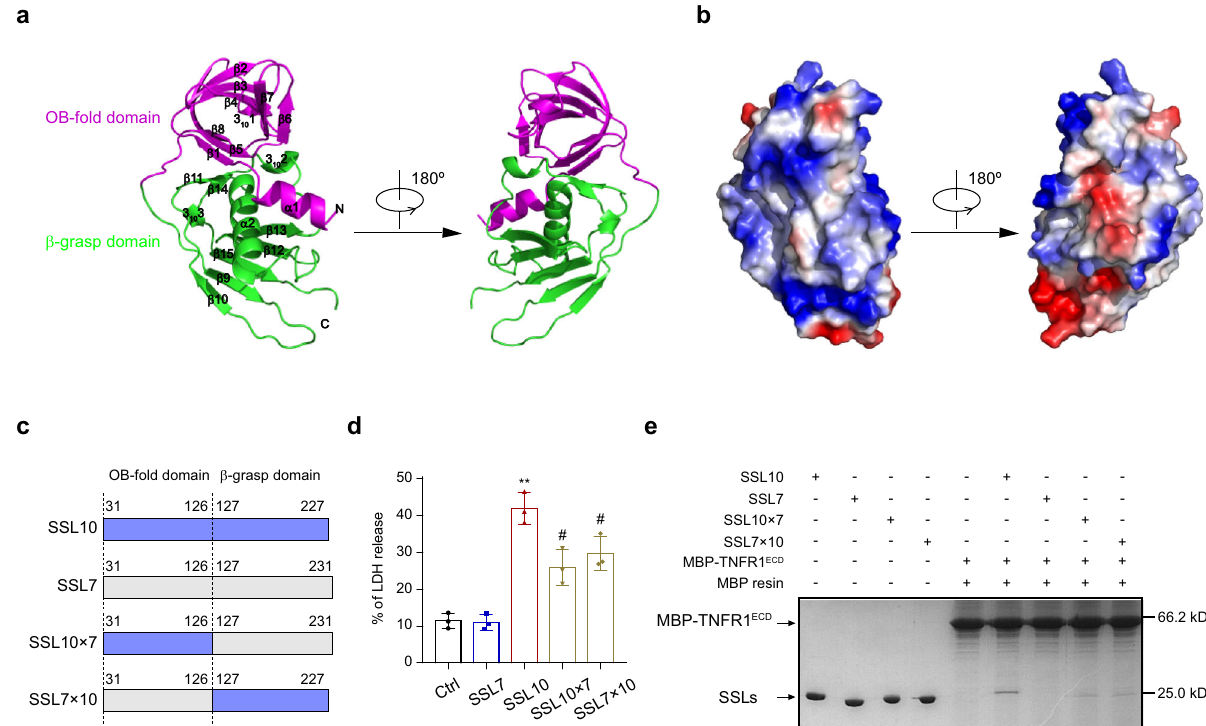
Fig. 5 Both the N- and C-terminal domains contribute to SSL10-induced necroptosis. a The overall structure of SSL10. The OB-fold domain and β -grasp domain of SSL10 are colored magenta and green, respectively. b The electrostatic surface potentials of SSL10. Positively and negatively charged surface regions are colored blue and red, respectively. c Illustration of chimeric SSL variants used in this study. Blue and gray boxes represent sequences derived from SSL10 and SSL7, respectively. The numbers indicate the residue positions of the N- and C-terminus of the swapped domains. d LDH released from HEK293T cells treated with 2 μ M SSL10, SSL7, SSL10 × 7, and SSL7 × 10. All data are presented as the means± SD from three independent experiments. * p < 0.05; ** p < 0.01 compared to the Ctrl cells (buffer-treated cells). # p < 0.05 compared to the SSL10 treated group, by one-way ANOVA. e MBP pull- down of SSL10, SSL7, SSL10 × 7 and SSL7 × 10 by MBP-TNFR1 ECD